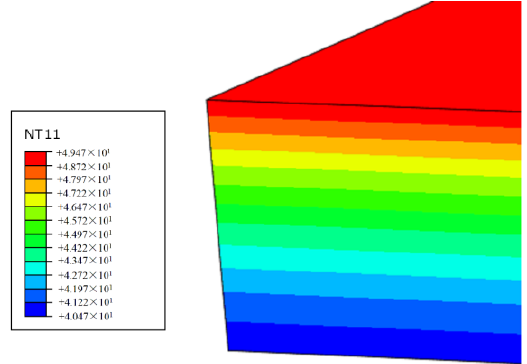
Figure 8. The temperature division of the slab track.